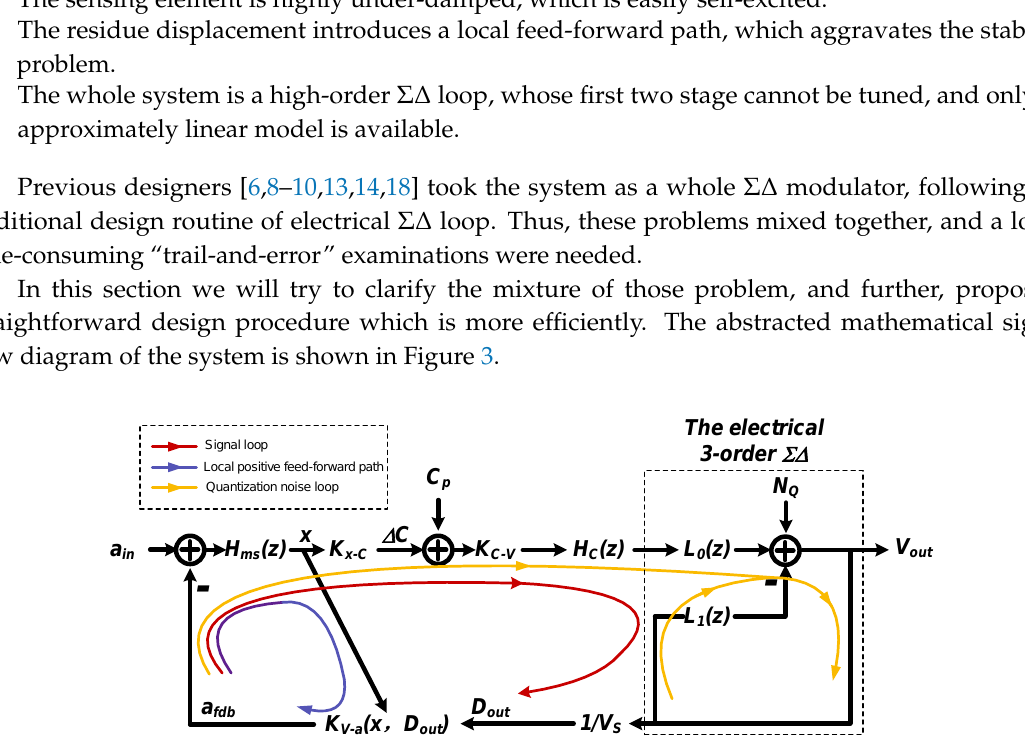
Figure 3. The abstracted signal flow diagram of the whole